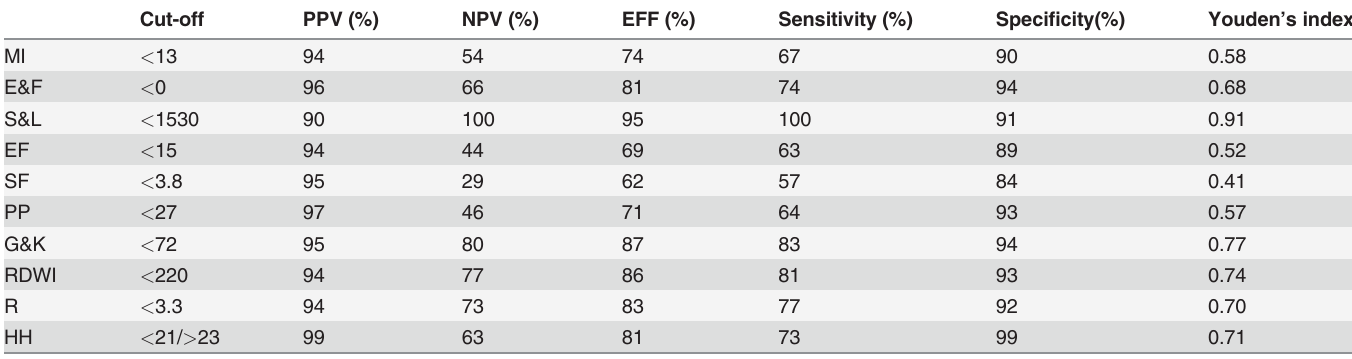
appeared to provide less accuracy in α -TM patients (YI < 0.7). All ten discrimination indices were unable to consistently and correctly identify patients with either α -TM or β -TT (data not shown). The best cut-off values for our cohort were calculated according to the AUC results, and the corresponding sensitivities and specificities of each formula are summarized in Tables 4 and 5. Among the ten indices, the G&K formula appeared to be the best predictor for identifying all of the thalassemia groups (Table 4). In addition to an increase in sensitivity from 83.6% to 89.62%, the specificity also increased from 94% to 96.2% when the cut-off value of the G&K formula was adjusted to less than 58.66 (AUC = 0.9716; p < 0.0001). The same result was ob- served with the RDWI formula. However, markedly decreased sensitivity and specificity were observed when the cut-off value of S&L was adjusted to less than 948.5. Seven of the ten formu- las and indices (excluding S&L, G&K and RDWI) exhibited increased sensitivity but impaired specificity when we applied the new cut-off points in our analysis. The same results were ob- served in a subgroup analysis of α -TM patients (Table 5).